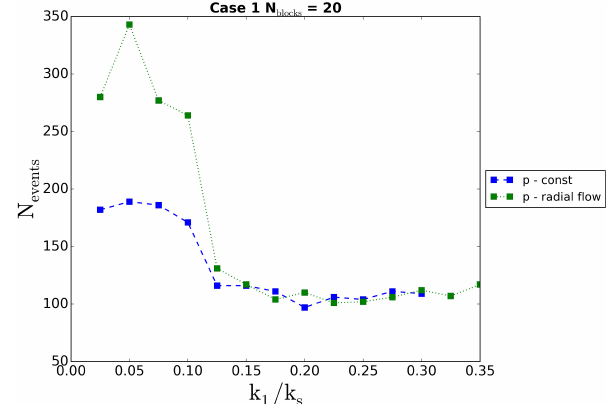
Figure 15. Cumulative seismic moment vs. number of blocks. Table 1. Values of coefficients A and k cr used in calculations.